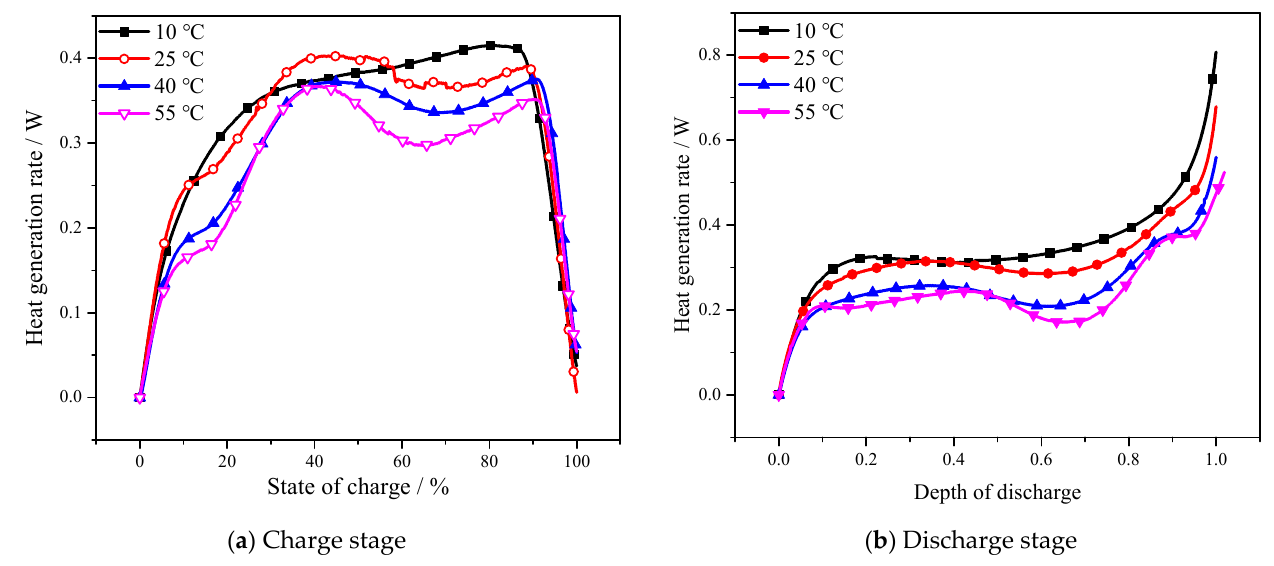
Figure 7. Effect of temperature on the heat generation rate during the charge and discharge stage of a NCM battery, under the same charge and discharge current of 2 A.